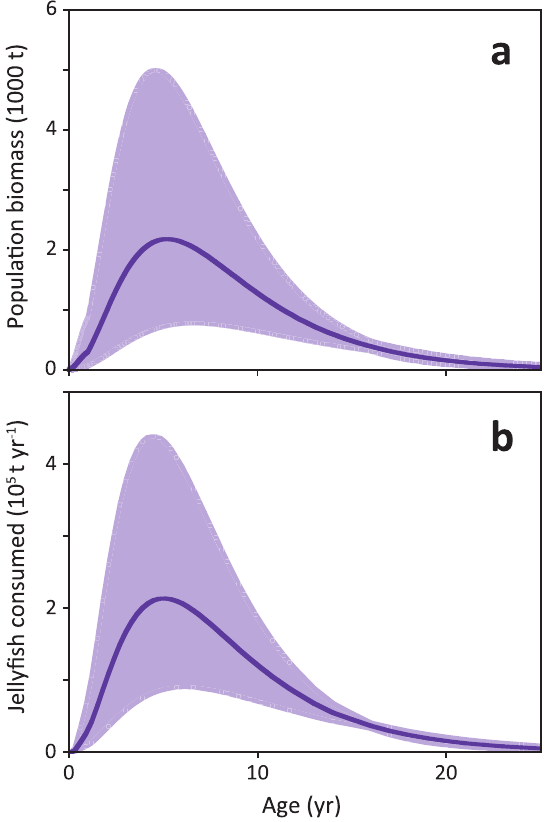
Figure 4. Total Pacific leatherback population biomass (a) determined by multiplying mortality with the VBGF for mass; and consumption rates in metric tonnes of jellyfish per year for the entire Pacific leatherback population (b) determined by multiplying mortality with food consumption rate. Solid dark purple line on plots a and b is the model average, purple shaded area is the 95% CI, obtained from Monte Carlo simulations of the input